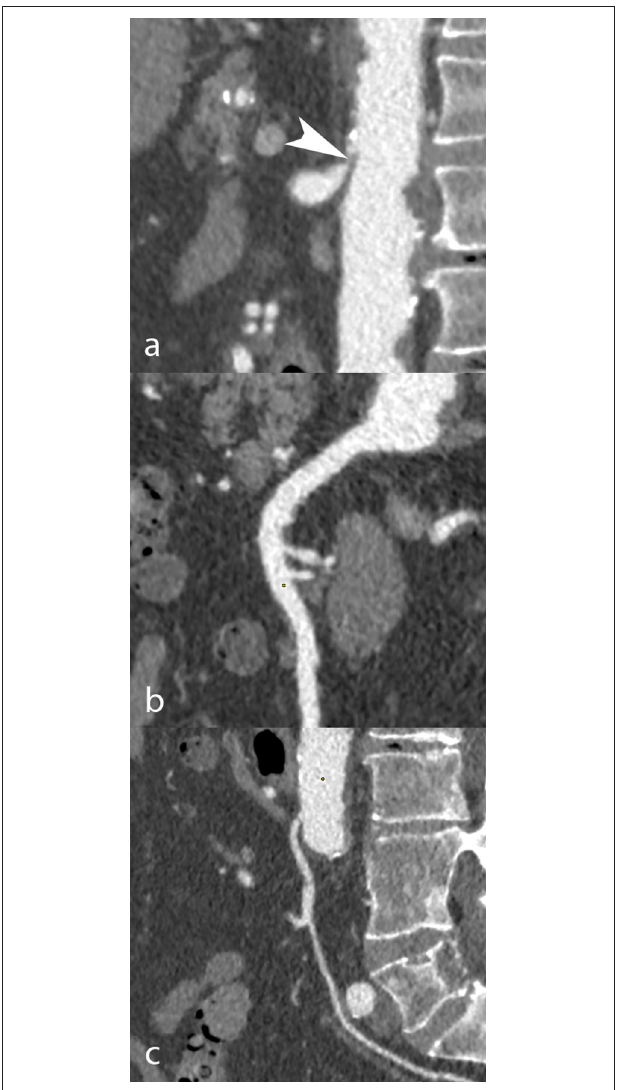
FIGURE 1 | CT angiography in an 85-year-old man scheduled to undergo TAVI. Curvilinear reconstructions show the coeliac trunk (a) , superior (b) , and inferior mesenteric artery (c) . While the coeliac trunk was occluded due to the combination of an arcuate ligament and a mixed plaque (white arrowhead), the mesenteric arteries had no occlusive